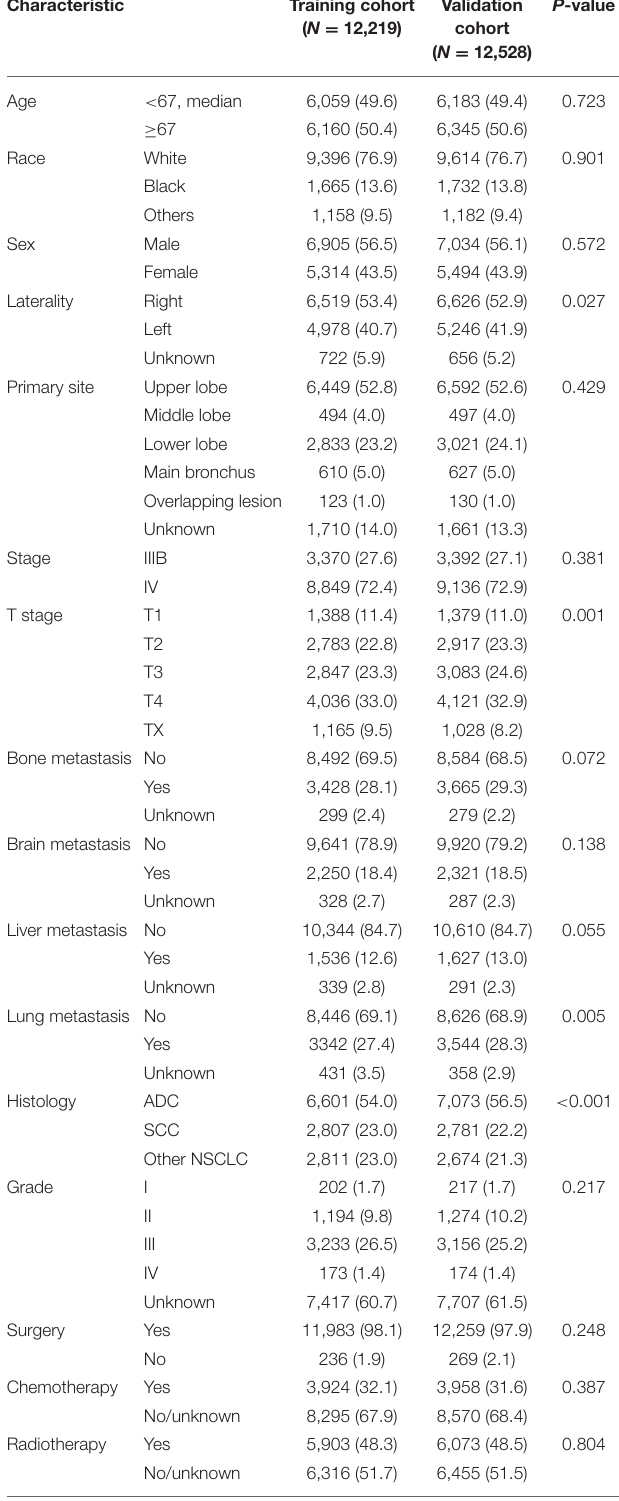
TABLE 3 | Baseline characteristics in the training and the validation cohorts of N3-NSCLC patients.